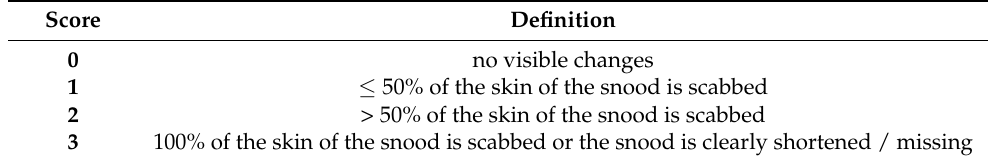
Table A5. Scoring system of the injuries on the snood [25].